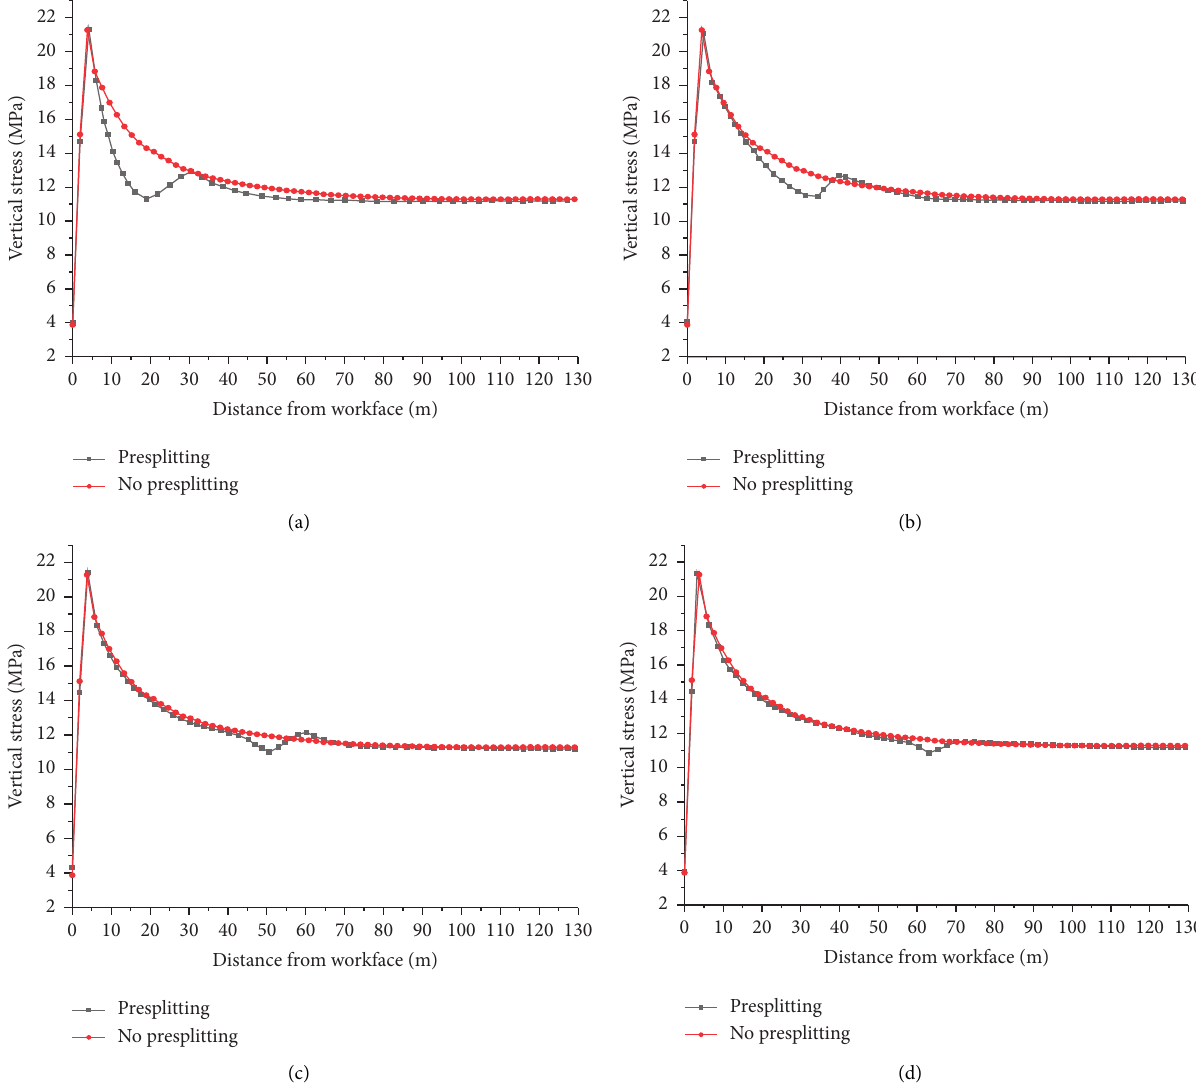
Figure 10: Vertical stress curves at different presplitting positions. (a) 20m ahead mining panel. (b) 35m ahead mining panel. (c) 50m ahead mining panel. (d) 65m ahead mining